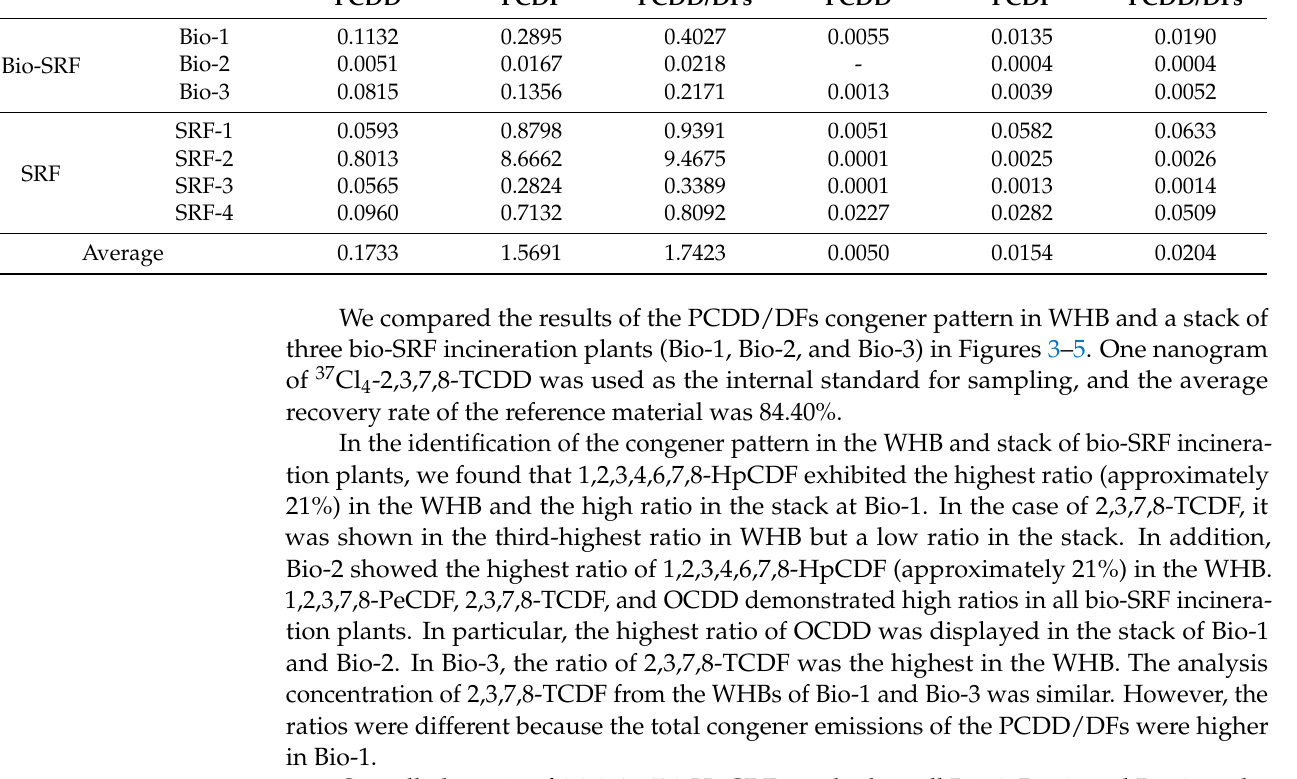
Table 5. PCDD/DFs concentration in WHB and stack (I-TEQ/Sm 3 ). WHB Stack